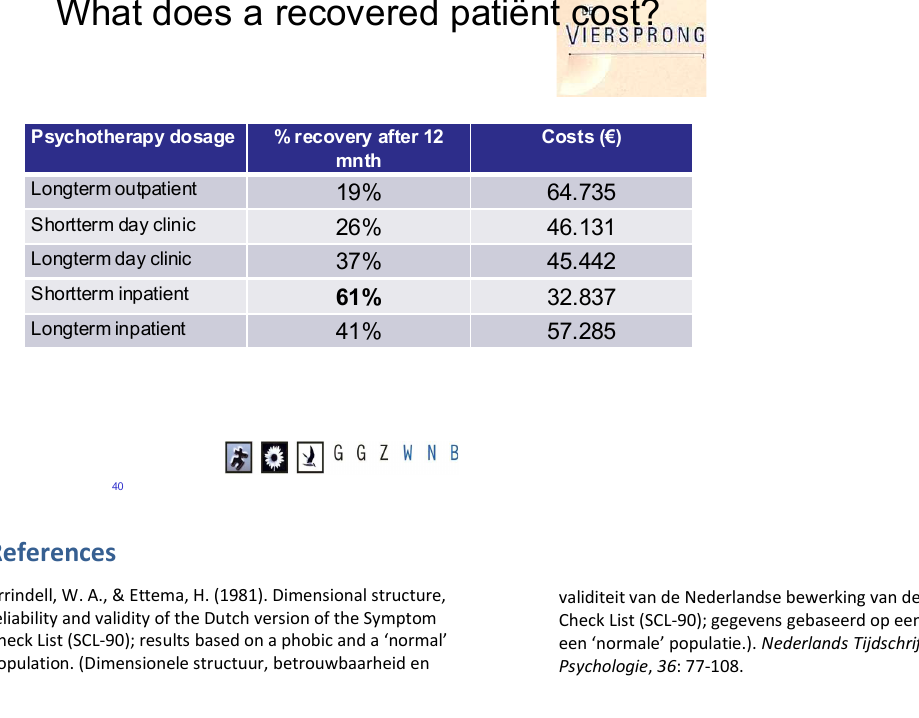
What does a recovered patiënt